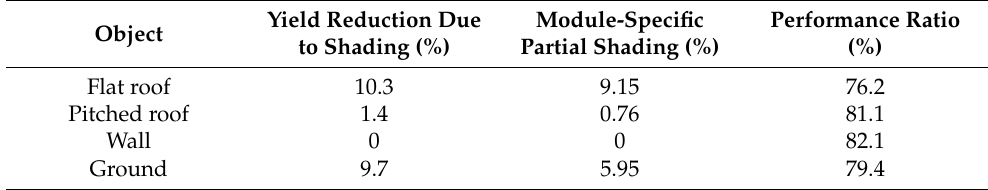
Performance Ratio (%)